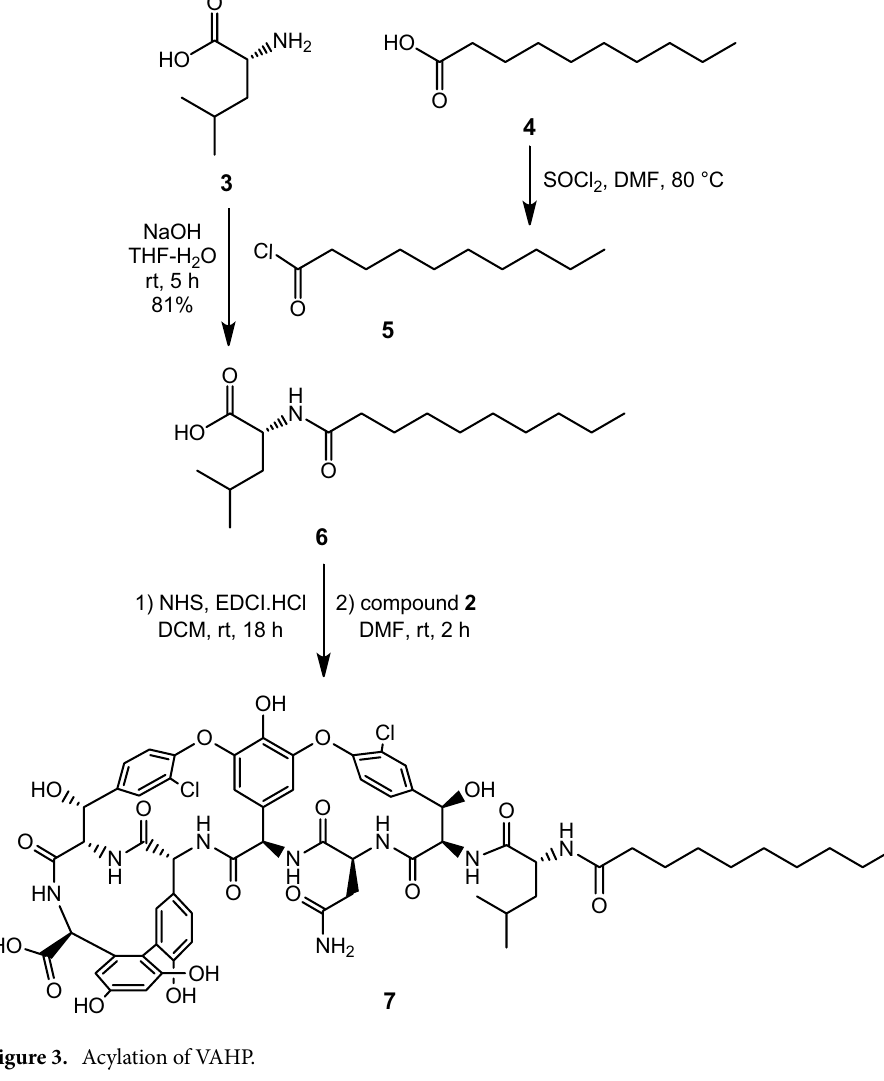
Figure 3. Acylation of